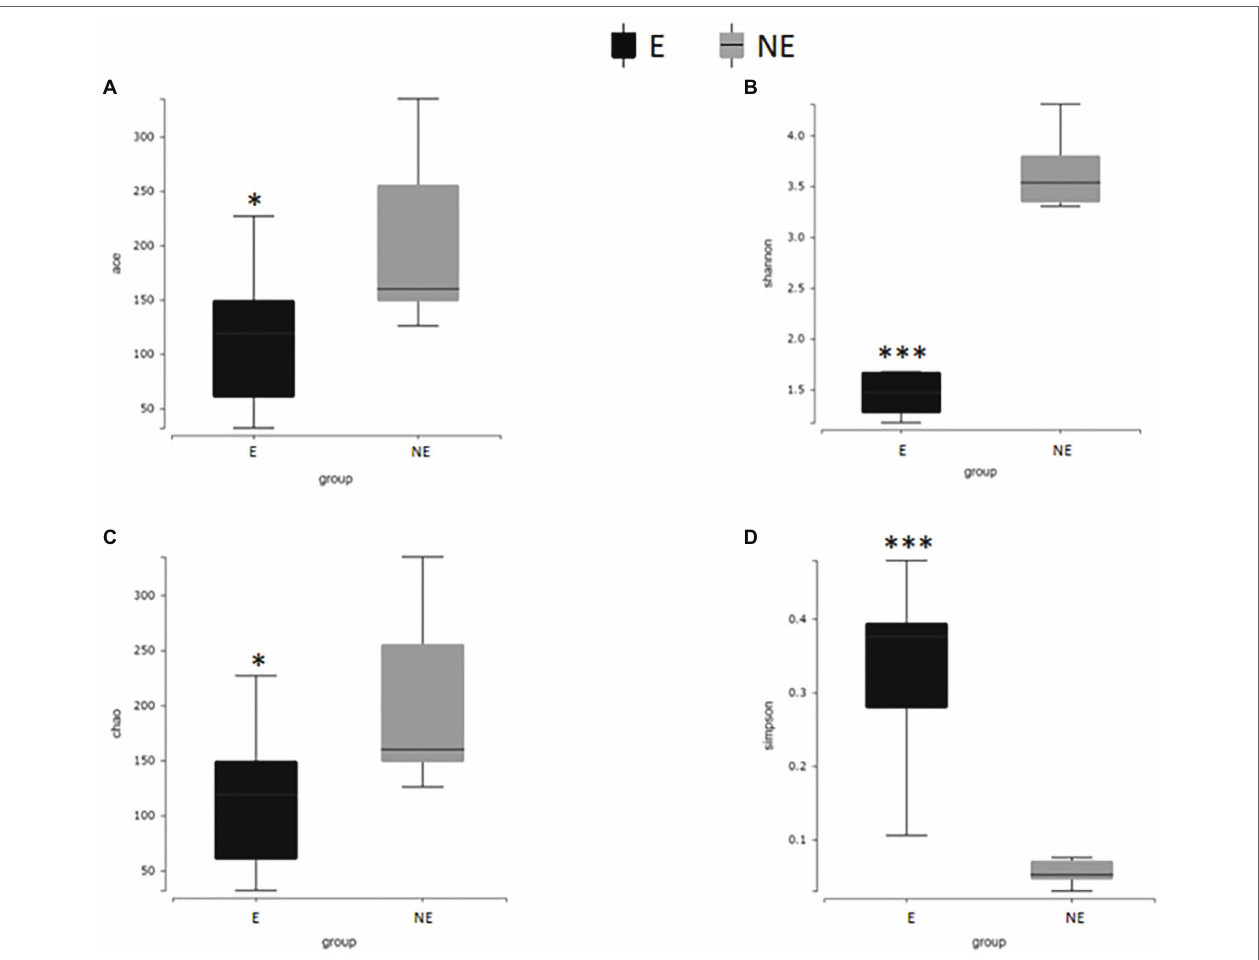
FIGURE 7 | Alpha diversity difference map of vaginal secretions in two groups. (A) The comparison result of ACE index; (B) the comparison result of Shannon index; (C) the comparison result of Chao1 index; (D) the comparison result of Simpson index ( p < 0.001, marked with “ *** ”; 0.001 < = p < = 0.01, marked with “ ** ”; 0.01 < p < = 0.05, marked with “ * ”; if p > 0.05, not